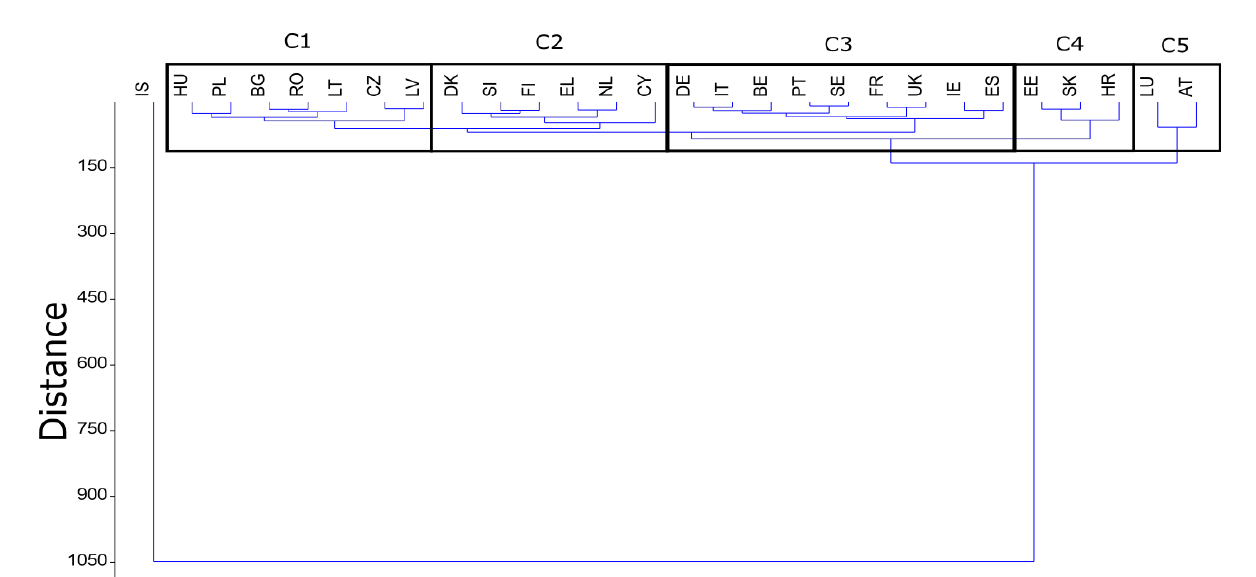
Figure 6. Clusters of GHG emission change (input: emissions of CO 2 , CH 4 and N 2 O in 2019 were divided by the emission of 1990, expressed in %, C1 – C5: clusters).